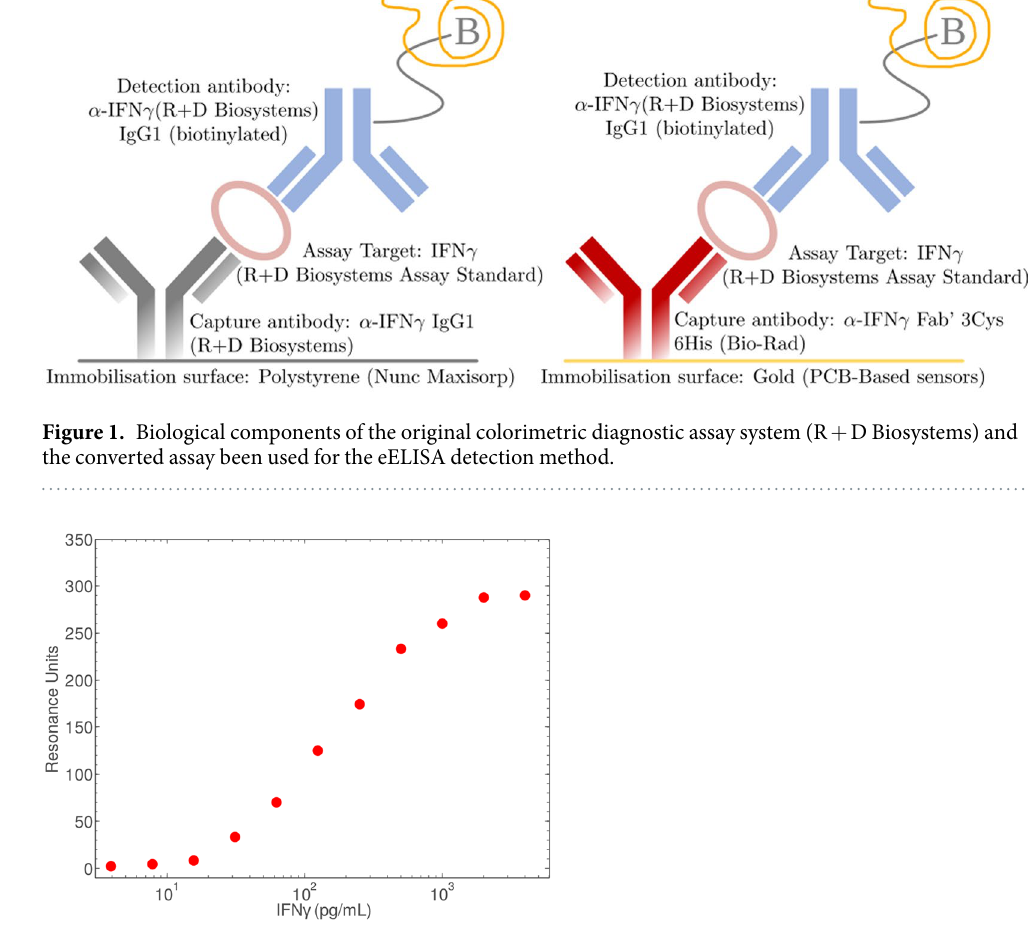
Figure 2. Characterisation of antibody-target interaction using SPR. A standard sigmoid binding curve is produced indicating standard 1:1 binding